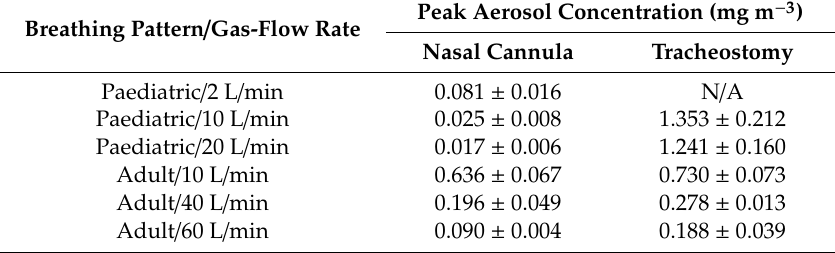
Table 2. Peak aerosol concentration recorded at a distance of 0.8 m from the patient interface. Each nebulisation event using simulated adult and paediatric breathing profiles for nasal cannula and tracheostomy interfaces, mean and standard deviations for each